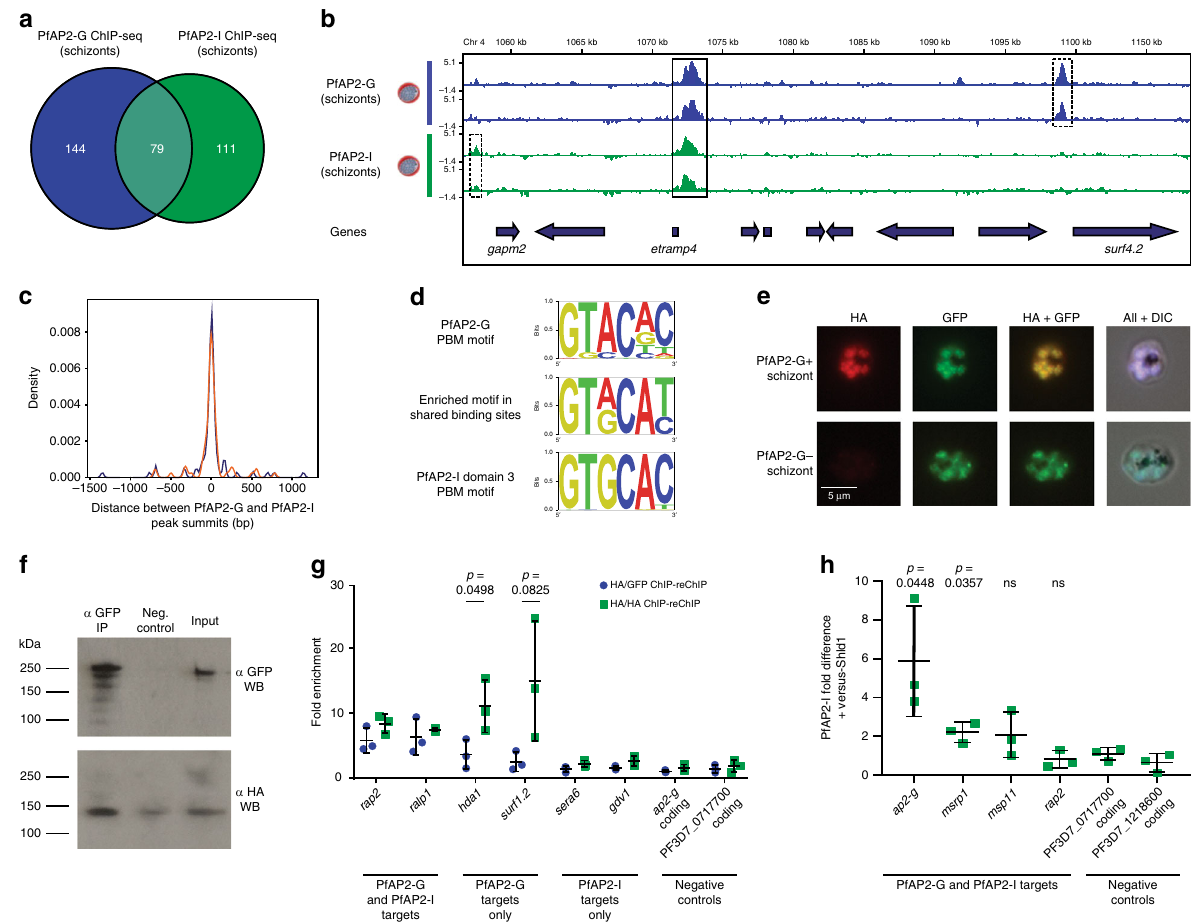
Fig. 5 PfAP2-G interacts with the transcription factor PfAP2-I. a Venn diagram showing overlap between PfAP2-G and PfAP2-I binding sites in schizonts in ChIP-seq experiments performed using a parasite line expressing both AP2-G-HA-DD and AP2-I-GFP. b Log2-transformed PfAP2-G (blue) and PfAP2-I (green) ChIP/input ratio tracks for schizonts over a region of chromosome 4. Dashed boxes highlight factor-speci fi c binding sites and solid boxes indicate common binding sites. The blue arrows underneath show the locations of genes. Data are shown for each of two biological replicates per factor. c Plot showing the distances between PfAP2-G and PfAP2-I peak summits within the 79 regions bound by both proteins. Replicate 1 is shown in blue and replicate 2 is shown in orange. d The top enriched motif (determined by DREME) found in the regions bound by both PfAP2-G and PfAP2-I is a composite of the PfAP2-G and PfAP2-I protein-binding microarray DNA motifs. e IFA images show that AP2-G + cells also express PfAP2-I, though not all cells express PfAP2-G. f Immunoprecipitation of AP2-I-GFP followed by Western blot with anti-HA and anti-GFP shows that PfAP2-I and PfAP2-G interact. The uncropped original image isprovided as a Source Data fi le. g ChIP-reChIP-qPCR shows PfAP2-G and PfAP2-I bind some gene promoters together in schizonts. Data are represented as fold enrichment relative to a negative control ChIP-reChIP with non-immune IgG. The horizontal bars indicate the mean and standard deviation. n = 3 biologically independent samples. Statistical signi fi cance was tested for using t-tests. h ChIP performed on PfAP2-I in schizonts shows that some sites have greater enrichment of PfAP2-I in the presence of PfAP2-G, indicative of cooperative binding. Data are represented as the fold change in enrichment of PfAP2-I in a cells treated with Shld1 versus those without Shld1. The horizontal bars indicate the mean and standard deviation. n = 3 biologically independent samples. t-tests were performed to compare the fold change for a region to that of the negative control (Pf3D7_071700 coding). ns = not statistically signi fi cant. Raw fold enrichment values are shown in Supplementary Fig. 12. Source data for panels g - h are provided as a Source Data fi